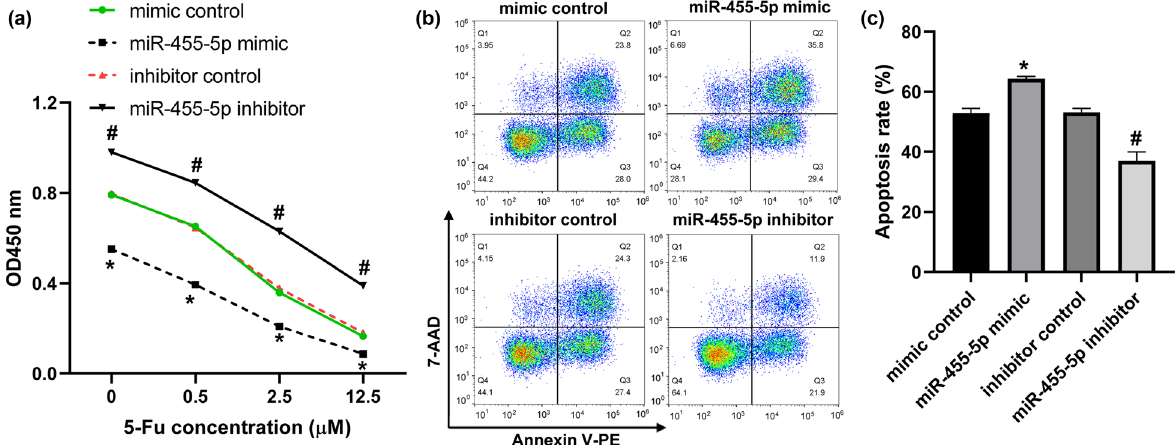
Figure 2: miR - 455 - 5p sensitizes CRC cells to 5 - Fu. ( a ) HT - 29 cells were transfected with miR - 455 - 5p mimic, inhibitor, and their corresponding control for 48 h, cell viability was analyzed by CCK - 8. ( b and c ) The apoptosis of HT - 29 cells was detected by fl ow cytometry. * P < 0.05 vs the mimic control, # P < 0.05 vs the inhibitor control.